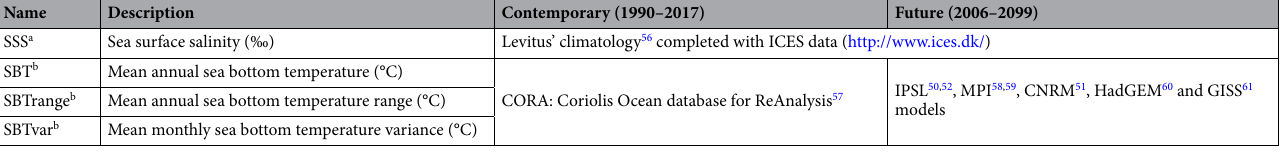
Table 1. Description of the environmental factors considered in the ensemble models and of the corresponding references. a Environmental factors kept constant in time. b Temperature corresponding to the bottom vertical layer down to a maximum depth of 500